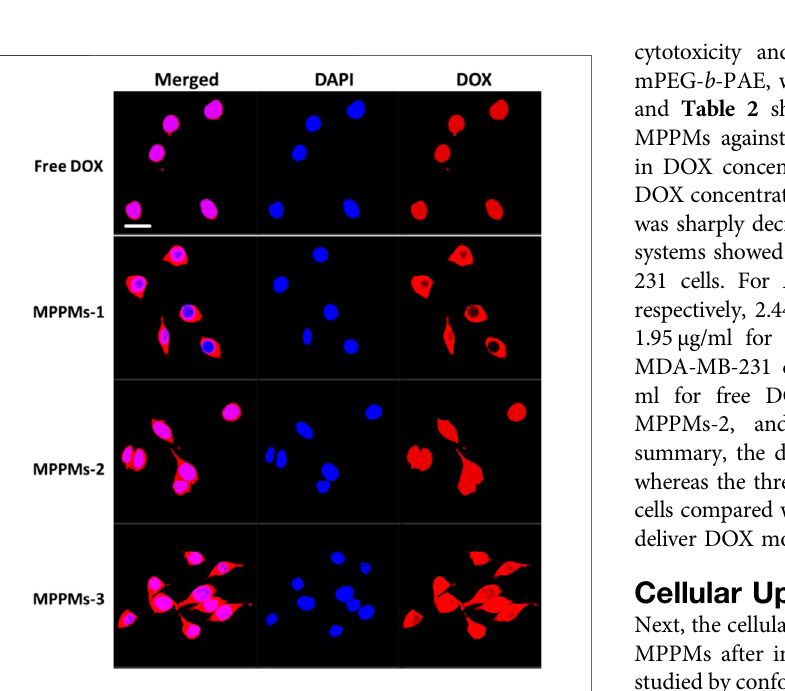
FIGURE 7 | CLSM images of MDA-MB-231 cells incubated with free DOX for 4 h. Merged images were overlap ofDAPI (blue) and DOX (red). Scale bar: 20 μ